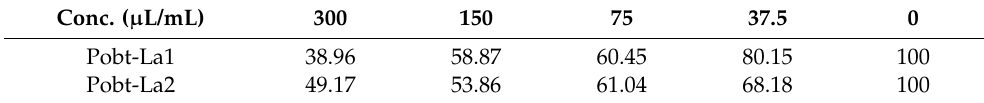
Table 2. Viability of HT-29 cells according to the concentration of postbiotics.